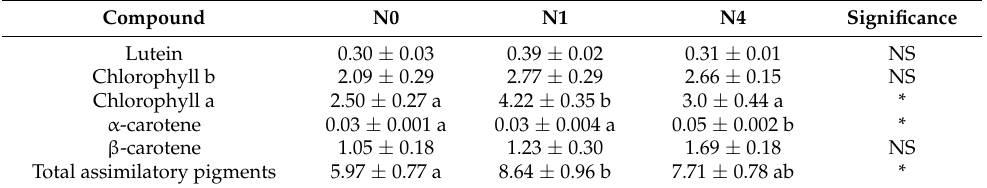
Table 4. Assimilatory pigments ( µ g g − 1 FW) of ‘Topaz’ apples subject to three urea treatments.